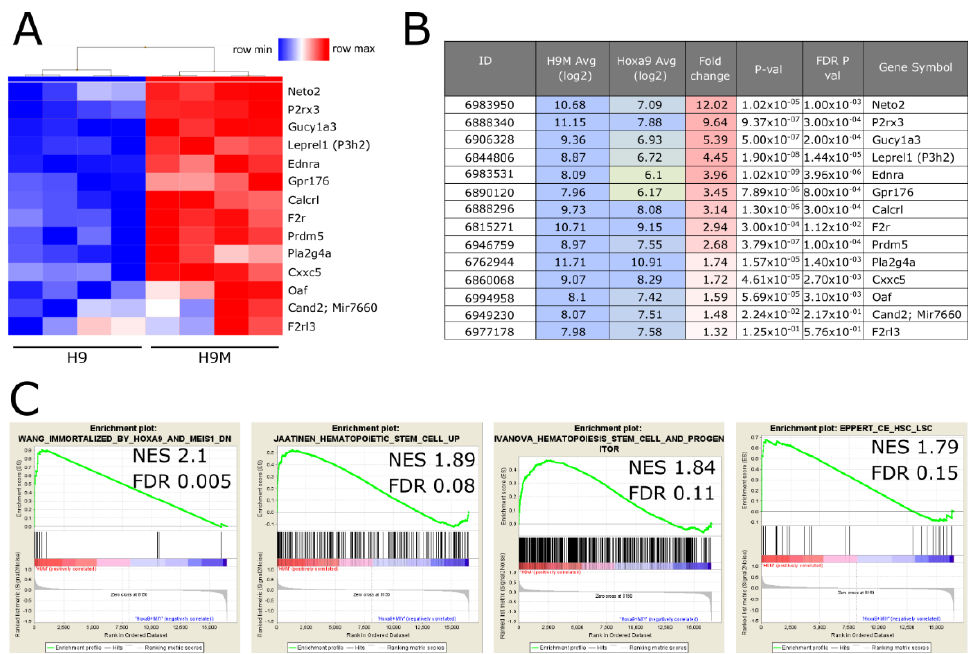
Figure 1. Gene expression analysis of Hoxa9 (H9) vs. Hoxa9/Meis1 (H9M) cells to identify leukemia- essential gene candidates. ( A ) Non-hierarchical clustering of genes selected for functional characterization. ( B ) Summary table of differentially expressed genes between H9M and H9 cells. ( C ) Gene set enrichment analyses. Based on the upregulated genes and those that cluster in the leading edge of the queried gene sets, a candidate gene panel was built for further evaluation.